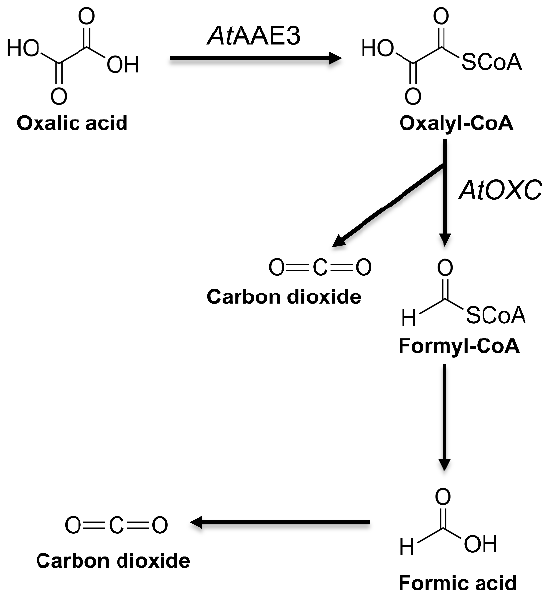
Figure 1. Proposed pathway of oxalate catabolism. AtAAE3, acyl-activating enzyme 3, which possesses an oxalyl-CoA synthetase activity [21], AtOXC, oxalyl-CoA decarboxylase (this study), and enzymes catalyzing the last two steps remain to be determined.